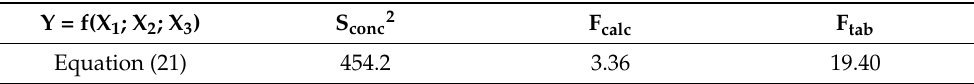
Table 7. Verification of the compliance between the calculated non-linear pattern according to Equation (21) and experimental results according to Table